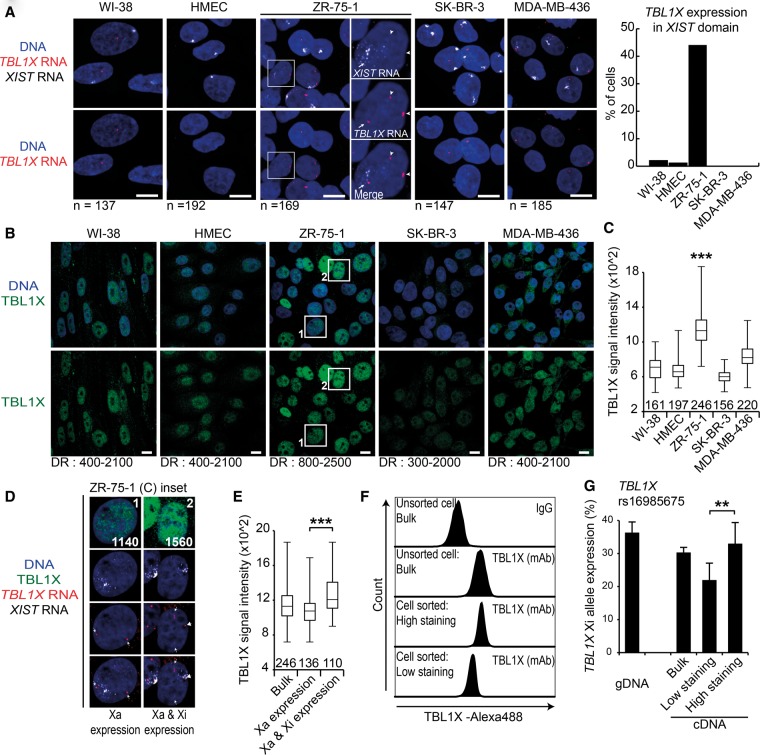
Reactivation of X-linked genes in breast cancer cell lines can lead to an increase of protein amount. (A) Z-projections of 3D RNA FISH show representative examples of TBL1X expression (red) at XIST domains (white) in normal (WI-38 and HMEC) and breast cancer cell lines (ZR-75-1, SK-BR-3, and MDA-MB-436). In ZR-75-1 cells, arrowheads indicate active X chromosomes and the arrow the XIST-coated chromosome. On the right, bar graph shows levels of TBL1X expression from XIST domains, with reactivation in ZR-75-1 cells. (B) Immunostaining shows TBL1X protein (green). The dynamic range (DR) of the brightness and contrast of each image (ImageJ) is indicated below. (C) Boxplot shows the intensity of TBL1X immunostaining for each cell line. The upper whisker represents the maximum value, upper quartile 75%, median 50%, lower quartile 25%, and lower whisker the minimum value of the data set. The number of nuclei analyzed is indicated above the x-axis. (***) P < 0.001 using the Student's t-test. WI-38, ZR-75-1, SK-BR-3, and MDA-MB-436 are compared with HMEC. (D) The inset of two ZR-75-1 nuclei from C shows a combination of TBL1X protein immunofluorescence staining (green) and RNA FISH for TBL1X (red) and XIST (gray). In the left nucleus, where TBL1X is expressed only from the active X chromosome, the IF signal intensity is 1140 a.u., whereas in the right nucleus, where both Xa and Xi TBL1X alleles are expressed, the intensity is as high as 1560 a.u. (E) Boxplot shows the levels of TBL1X signal intensity either in the whole cell population (bulk; left box) or in cells in which TBL1X is expressed only from the active X chromosome (middle box) or when TBL1X is expressed from all X chromosomes (right box). The upper whisker represents the maximum value, upper quartile 75%, median 50%, lower quartile 25%, and lower whisker the minimum value of the data set. Nuclei number analyzed is indicated above the x-axis. (F) Cell sorting of ZR-75-1 cells based on TBL1X signal intensity. An IgG antibody has been used as negative control. (G) Bar graph shows the level of TBL1X expression from the XIST-coated X chromosome by pyrosequencing at SNP rs16985675. Left bar represents the gDNA control, which is in agreement with the allelic imbalance (i.e., one Xi allele and two Xa alleles). Data represent the mean values ±SEM. (***) P < 0.001; (**) P < 0.01; (*) P < 0.05 using the Student's t-test.